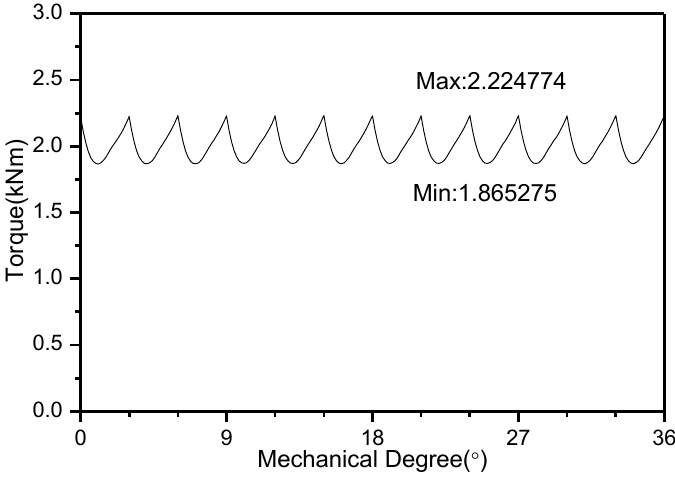
Figure 23. Steady-state torque of the brushless DC motor at rated speed.